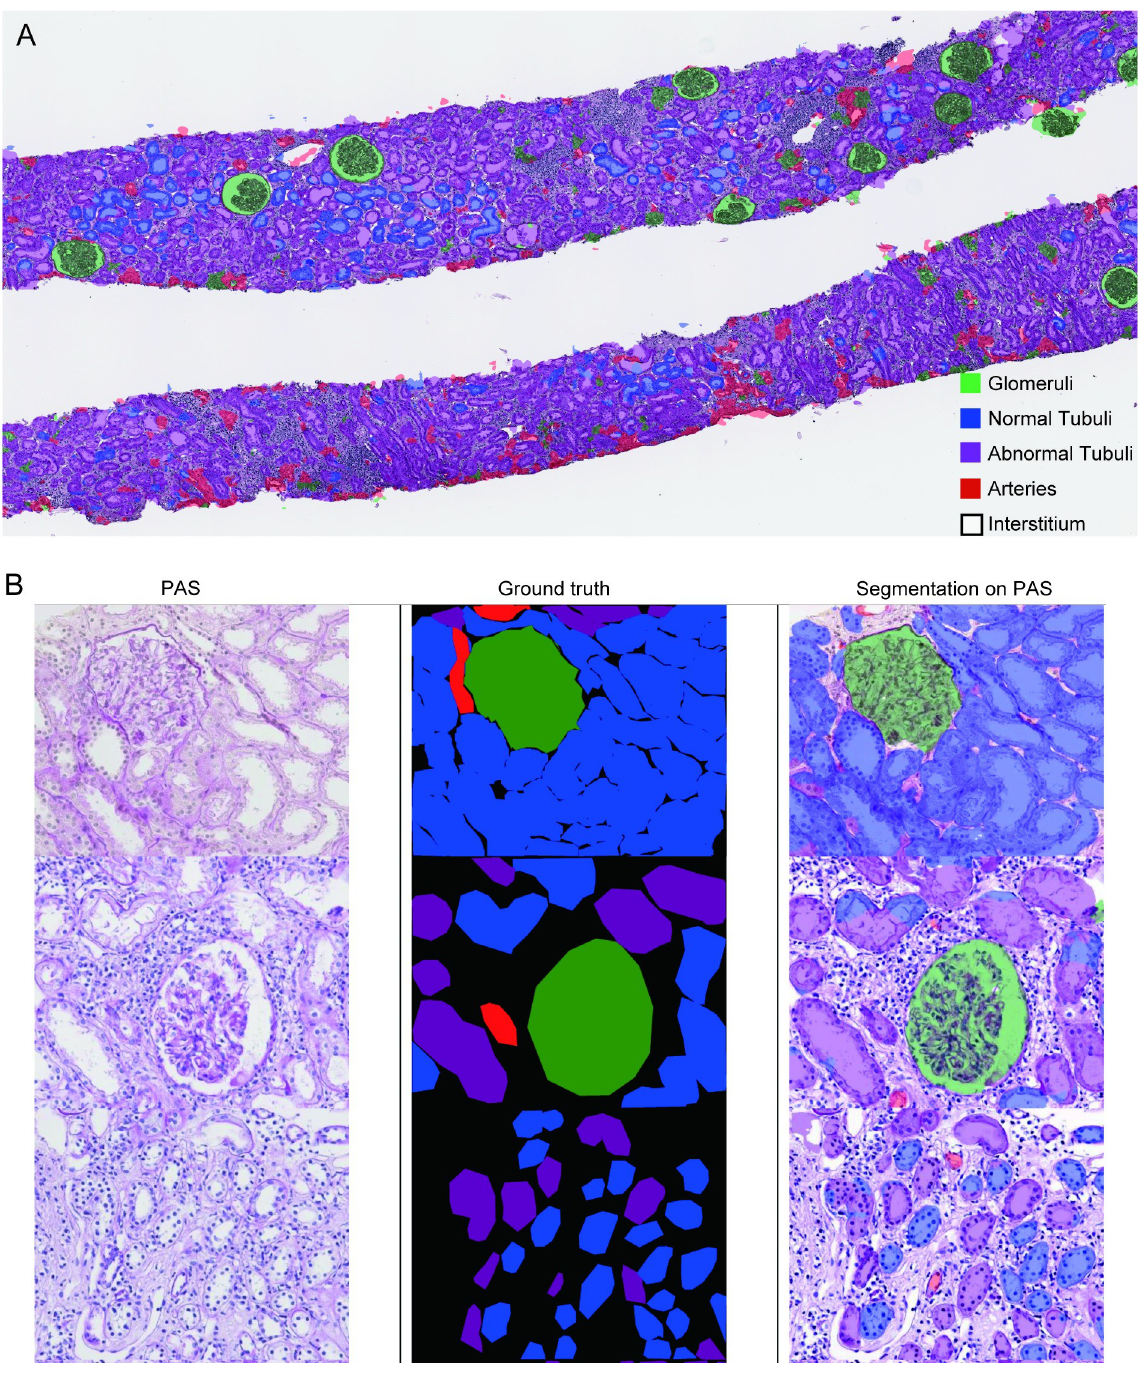
Fig 1. Representative images of ground truth and eight-class segmentation using U-Net. (A) Whole-slide image of segmentation using U-Net in a specimen with tubulointerstitial nephritis. (B) PAS-stained slide, ground truth, and segmentation using U-Net. The top row represents a normal specimen; the middle and bottom rows represent specimens with tubulointerstitial nephritis.